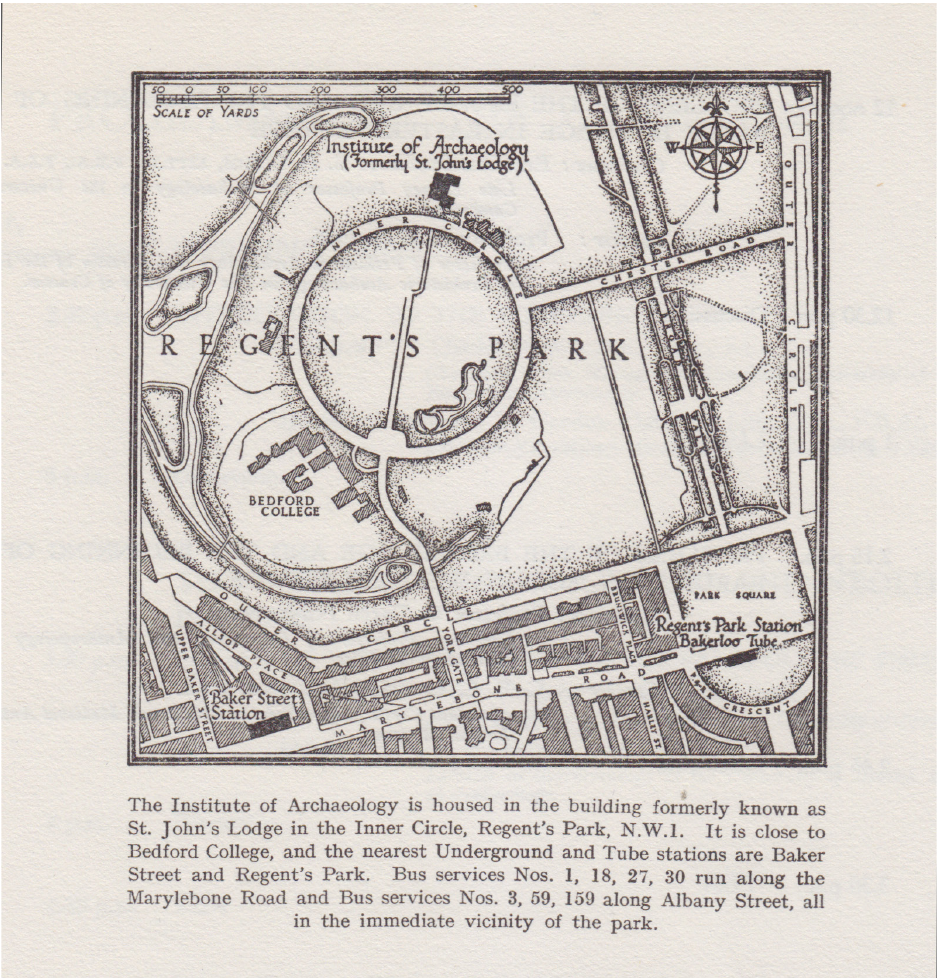
Fig. 1: Map showing the location of the Institute of Archaeology at St John’s Lodge, Regent’s